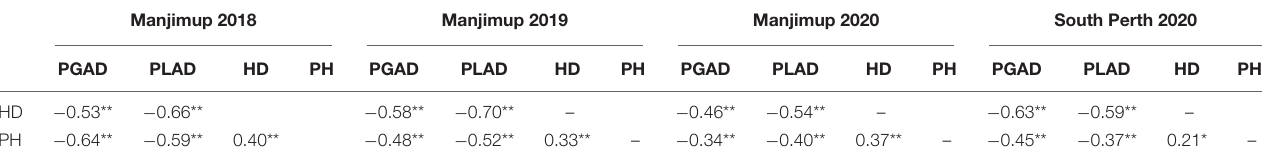
TABLE 3 | Phenotypic correlations ( r ) between percent glume and leaf area disease (PGAD and PLAD, respectively), heading date (HD) and plant height (PH) at four environments in Western Australia in